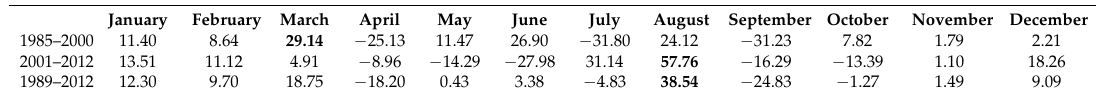
Table 8. Changes of precipitation (in mm) during different periods relative to the baseline period (1960–1984) for the Qingliu River basin, East